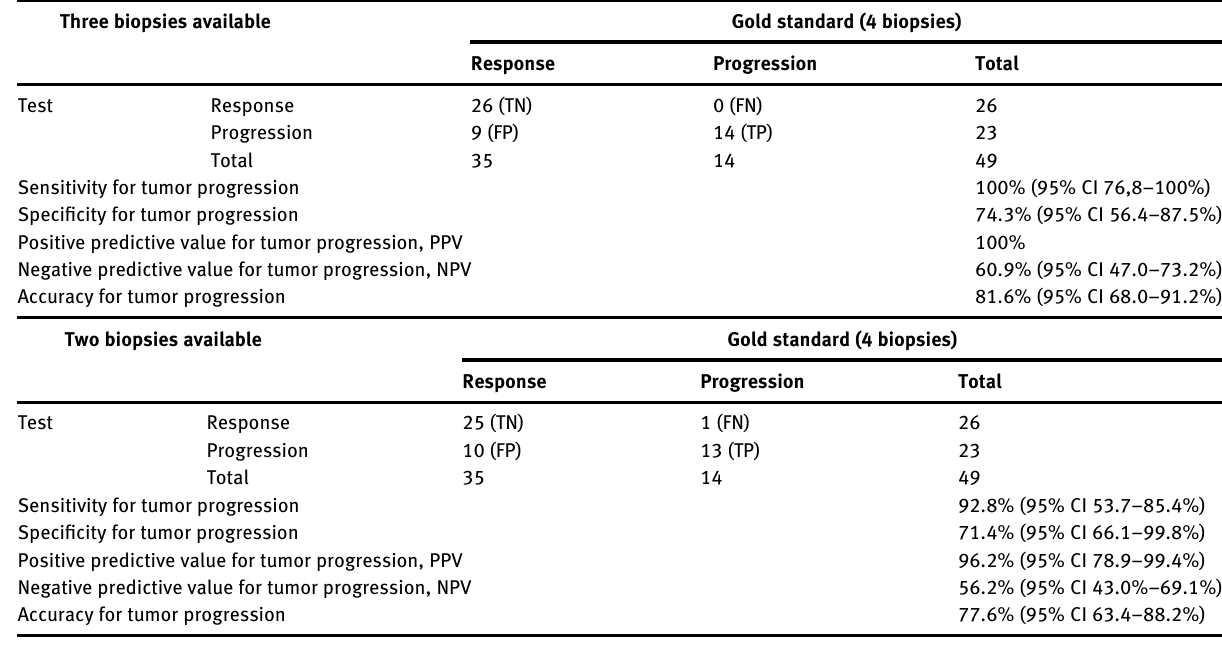
Table  : Performance metrics of PRGS score for prediction of tumor progression with one or two biopsies missing. Three biopsies